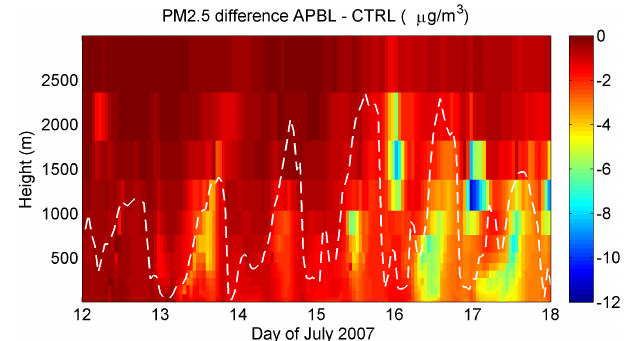
Figure 14. Difference in the simulated PM 2 . 5 profile over Milan between APBL and CTRL runs (see Table 2). In combination with Fig. 6b, this is useful for estimating the impact of the aerosol resid- ual layer on ground